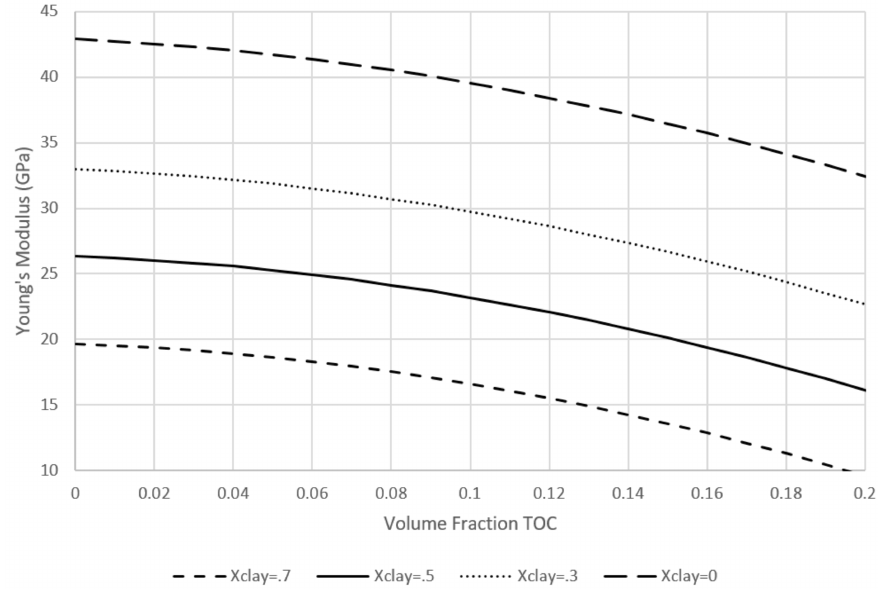
Figure 8. Relationship between Young’s modulus and volume fraction of TOC for lines of constant clay content. Equations (9)–(11) are used to show the compositional dependence of Young’s modulus. Lines are for di ff erent constant volume fractions of clay (X CLAY ) of 0.7 (dashed line), 0.5 (solid line), 0.3 (dotted line), and 0 (long dashed line) from the regression Equations (9) and (10) and elastic moduli relationships (11) and (12). These trends represent average shale reservoir properties in our dataset and may vary somewhat in di ff erent